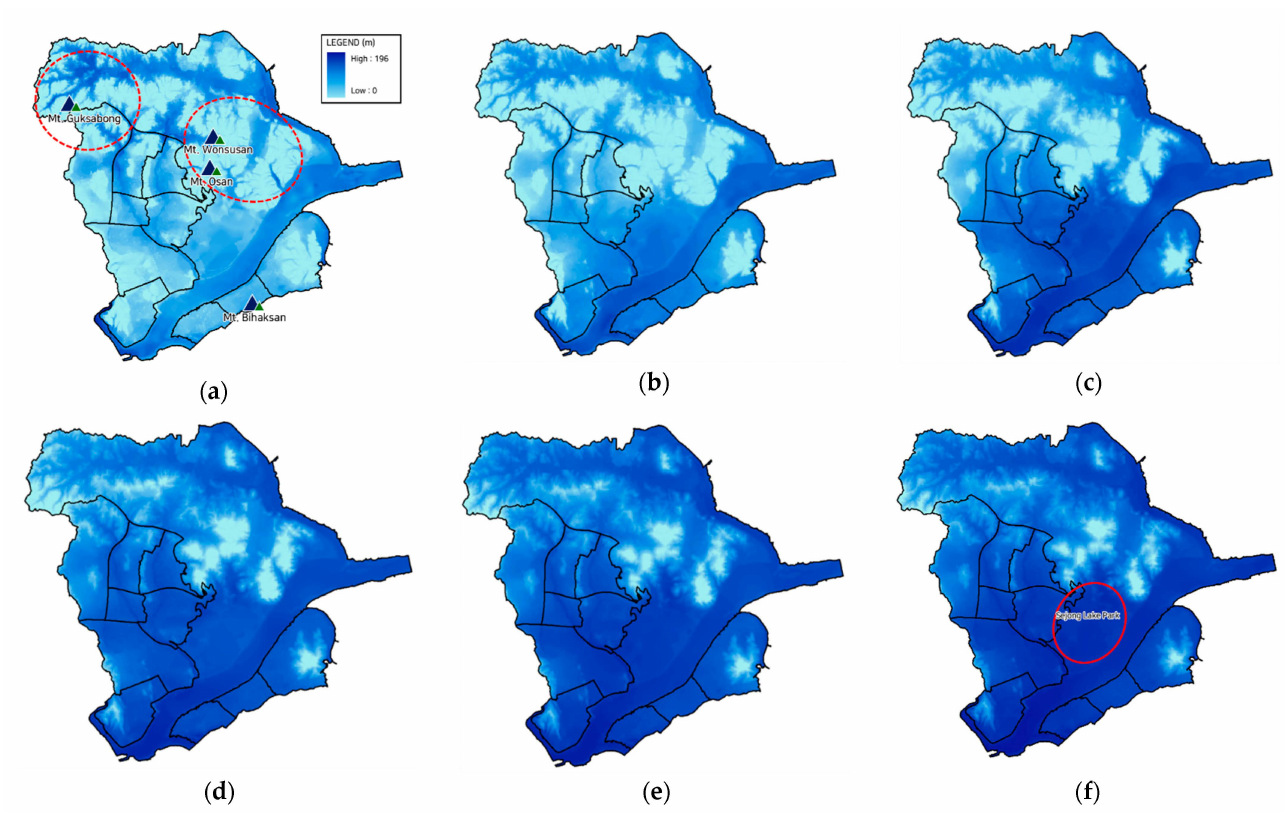
Figure 9. The height of cold air layer by minute after the start of cold air generation in HBC region: ( a ) 60 min; ( b ) 120 min; ( c ) 180 min; ( d ) 240 min; ( e ) 300 min; ( f ) 360 min.